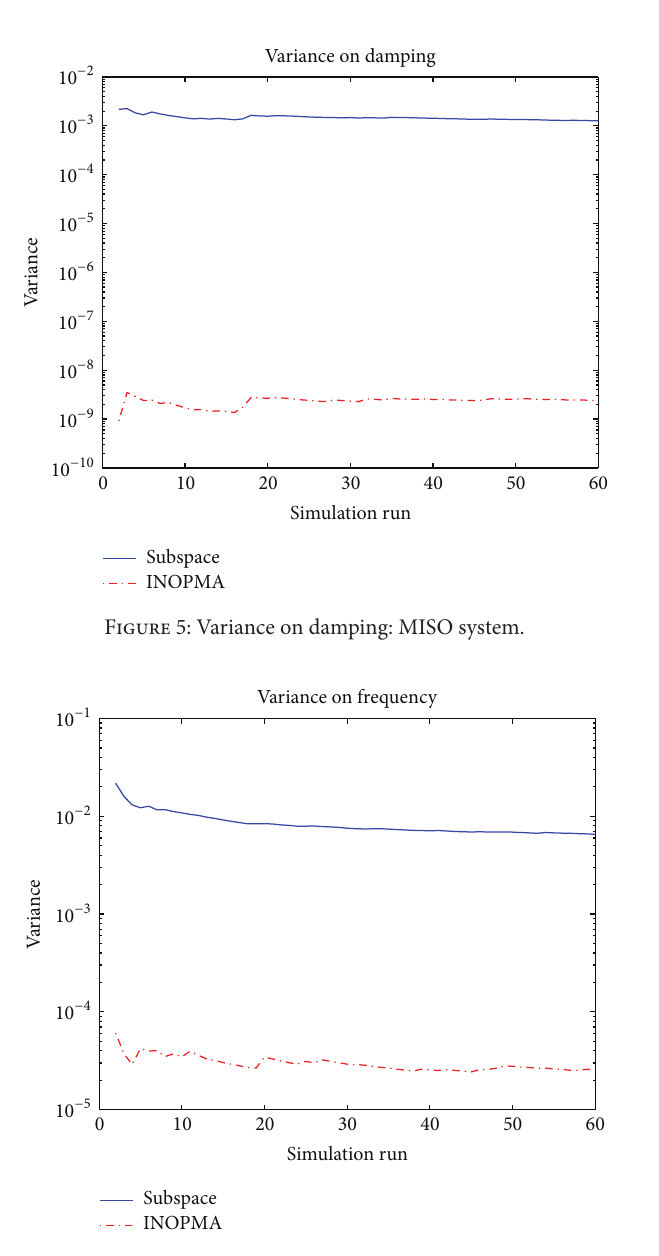
Figure 6: Variance on frequency: MISO system.